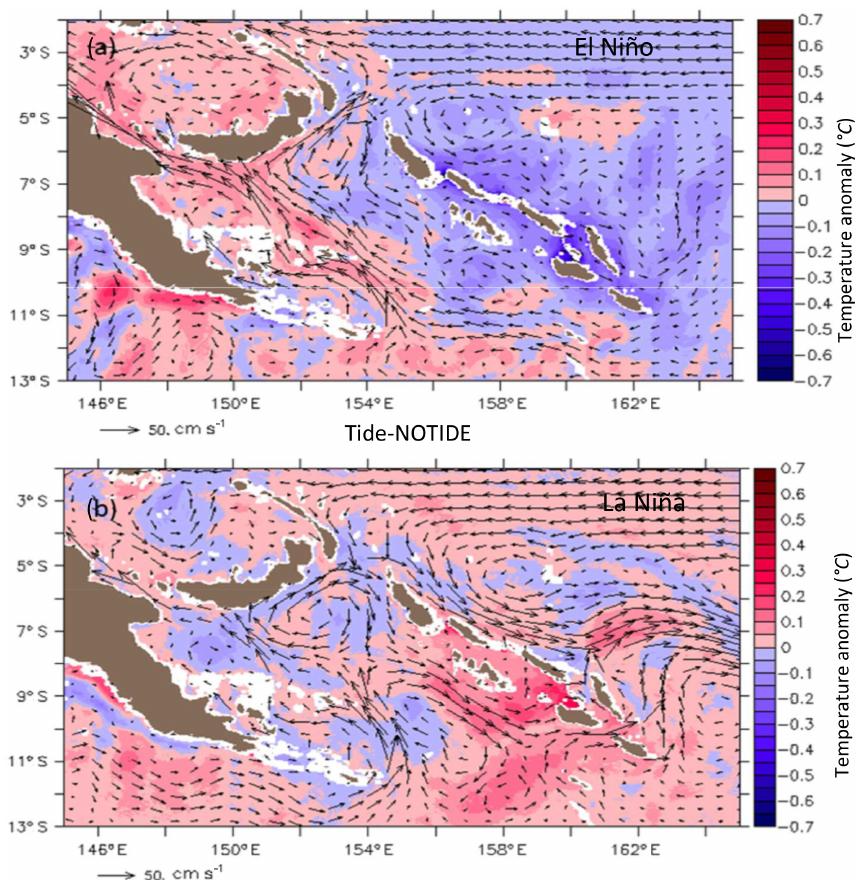
Figure 14. TIDE–NOTIDE Temperature anomalies (in color, ◦ C) and mean circulation (arrows) for the SW waters during (a) the El Niño period and (b) the La Niña period. Isobathymetric lines are from the NOAA/ETOPO2v2 bathymetric file from the Smith & Sandwell database (https://doi.org/10.7289/V5J1012Q, National Geophysical Data Center, 2006). White color is for bathymetry of less than